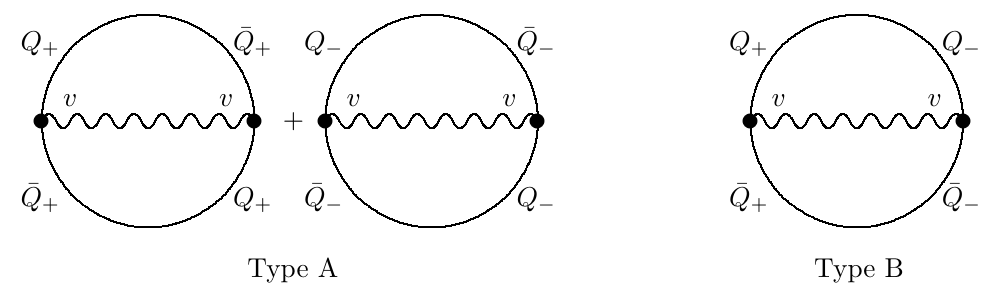
Figure 1 . Two-loop supergraphs in N = (2 ; 2) supersymmetric